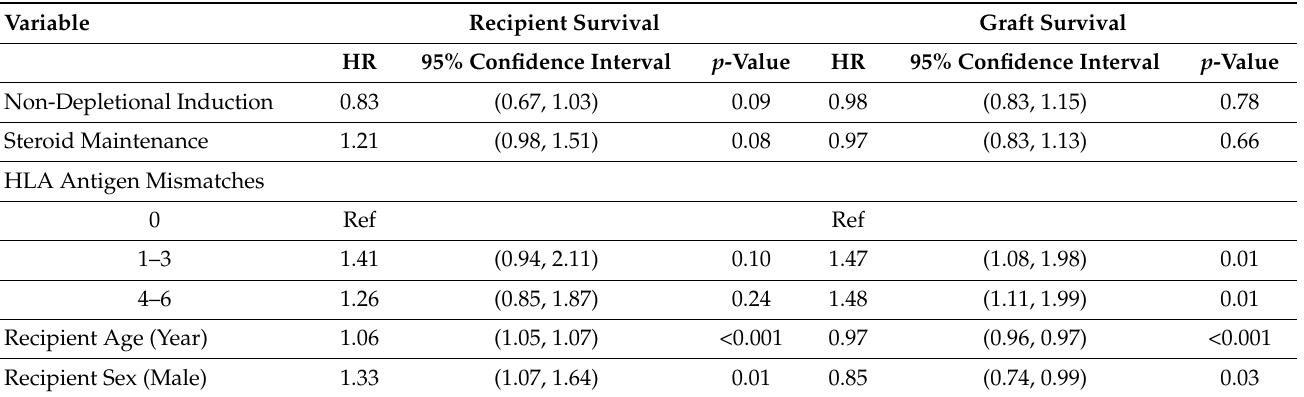
Figure 4. Univariable Kaplan–Meier Estimates of Recipient Survival (RS) and Death-Censored Graft Survival (DCGS) by Induction Type and Steroid Maintenance in IgAN. Table 2. Multivariable Cox Proportional Hazards Models for Recipient and Death-Censored Graft Survival in IgA